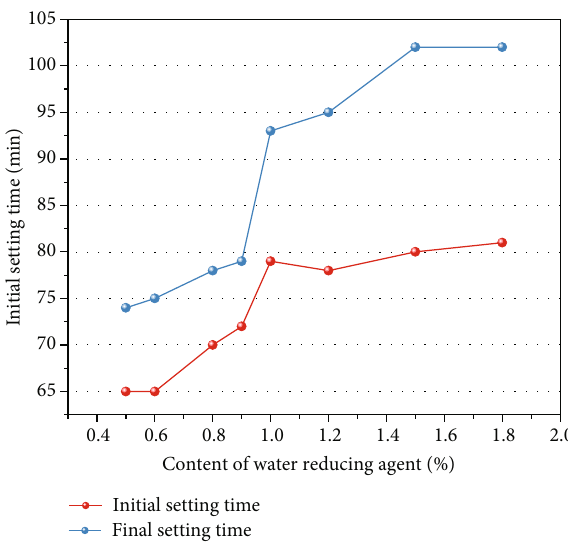
Figure 16: The e ff ect of di ff erent dosages of superplasticizer on setting time.